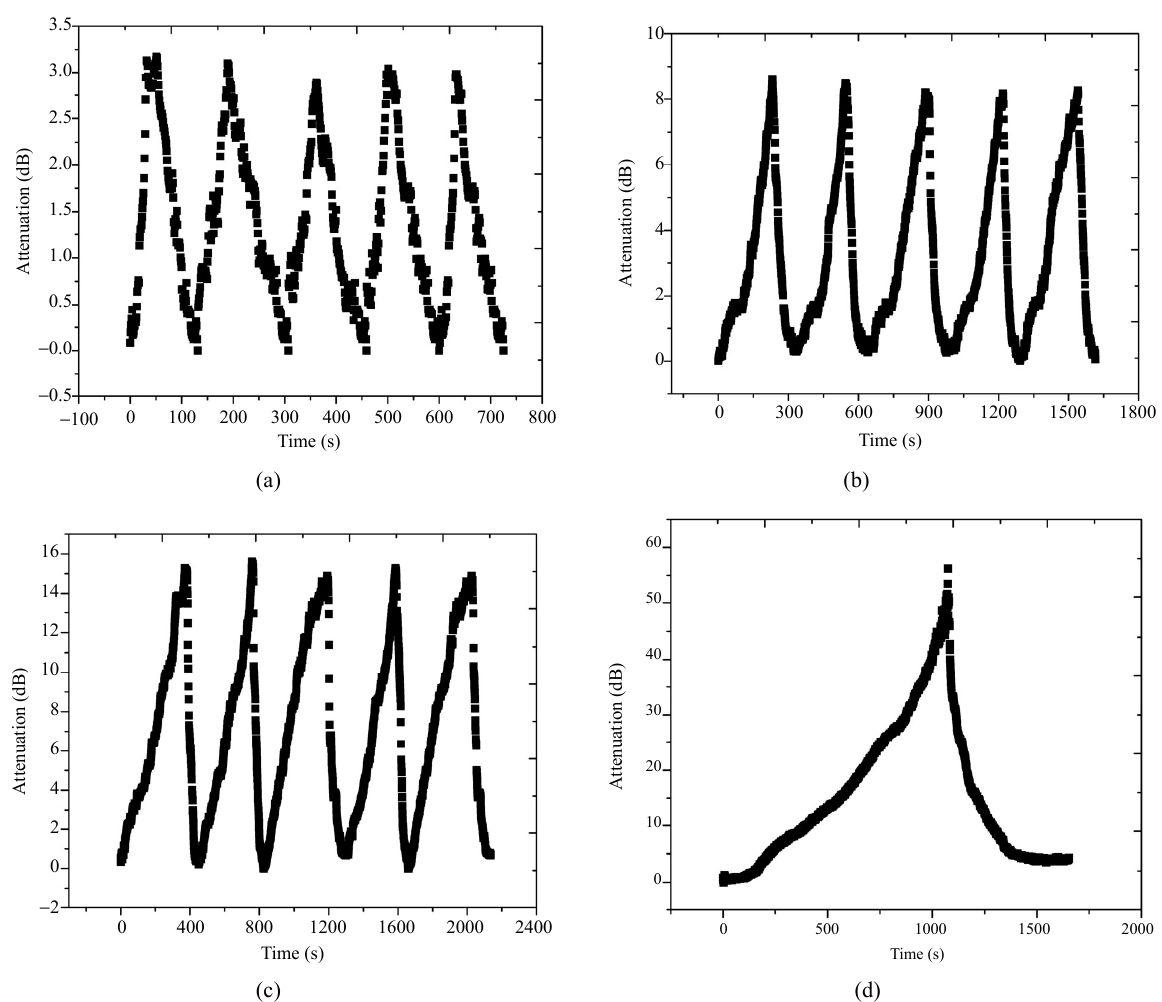
Fig. 6 Change in attenuation when humidity increases in the humidity-controlled box at (a) 63% RH, (b) 66% RH, (c) 70% RH, and (d) 90%